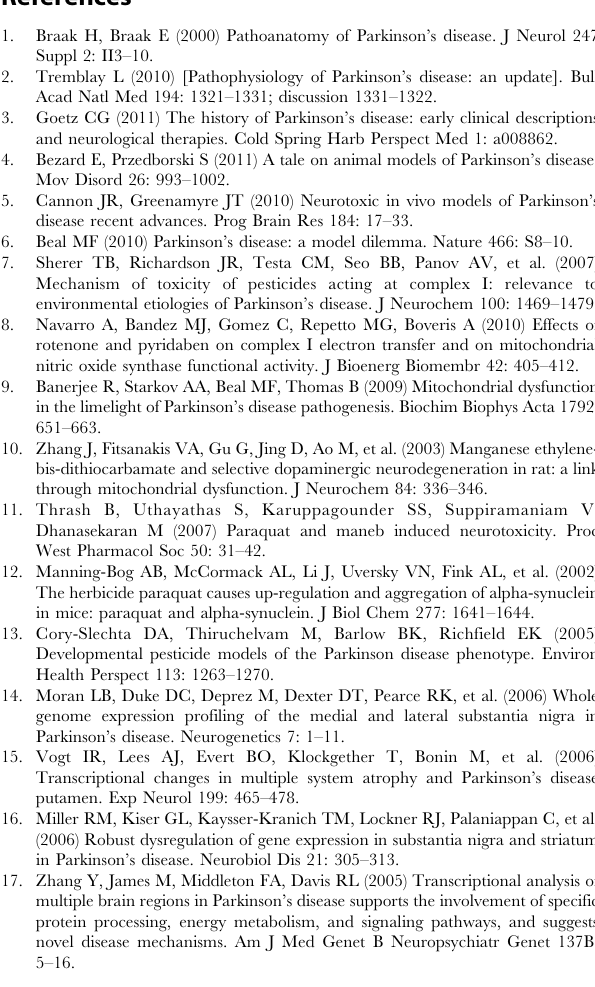
Table S1 Top genes and their expression levels in VMB of paraquat, pyridaben and maneb + paraquat mouse models of PD. Table S2 Top genes and their expression levels in STR of paraquat, pyridaben and maneb + paraquat mouse models of PD. Table S3 Top ten canonical pathways in VMB of paraquat mouse model of PD Table S4 Top ten canonical pathways in VMB of pyridaben mouse model of PD